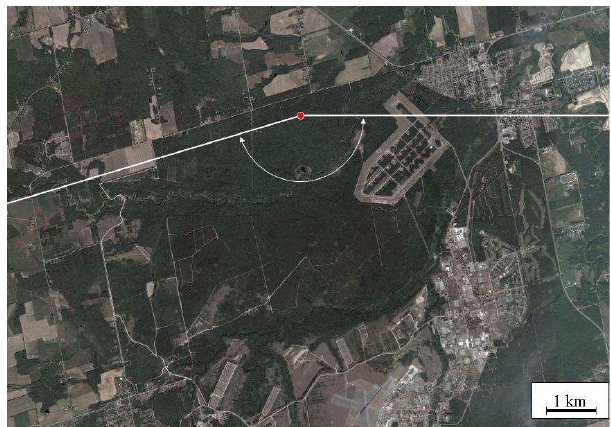
Fig. 1. Borden and surrounding area. Red dot shows tower location. Figure 1. Borden and surrounding area. Red dot shows tower location. Arrows show range 2 Arrows show range of wind direction with adequate fetch. Photo of wind direction with adequate fetch. Photo reproduced from Google.com. 3 reproduced from